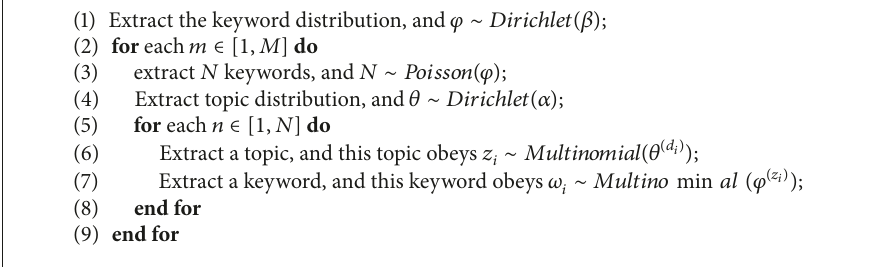
Algorithm 1: The generative process of